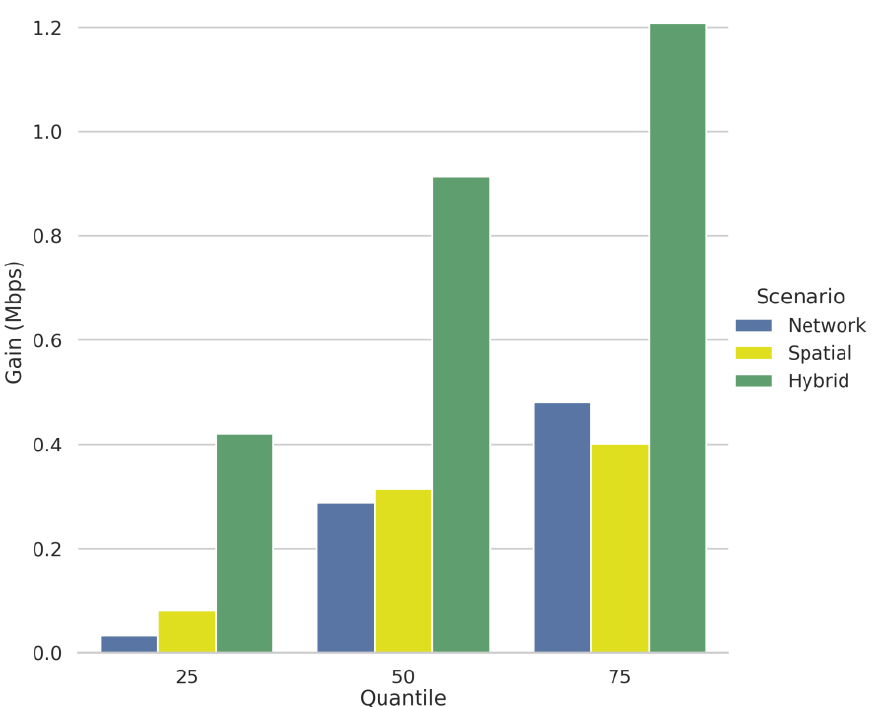
Figure 12. Comparison between the different algorithms’ improvement vs. the baseline for per user normalized throughput gain (Mbps).